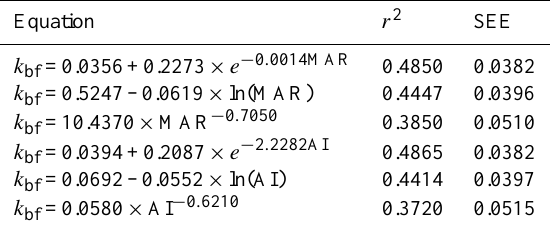
Table 3. Summary of results, including r 2 and standard error of es- timate (SEE) for the exponential, logarithmic and power regressions linking k bf with MAR and AI ( n